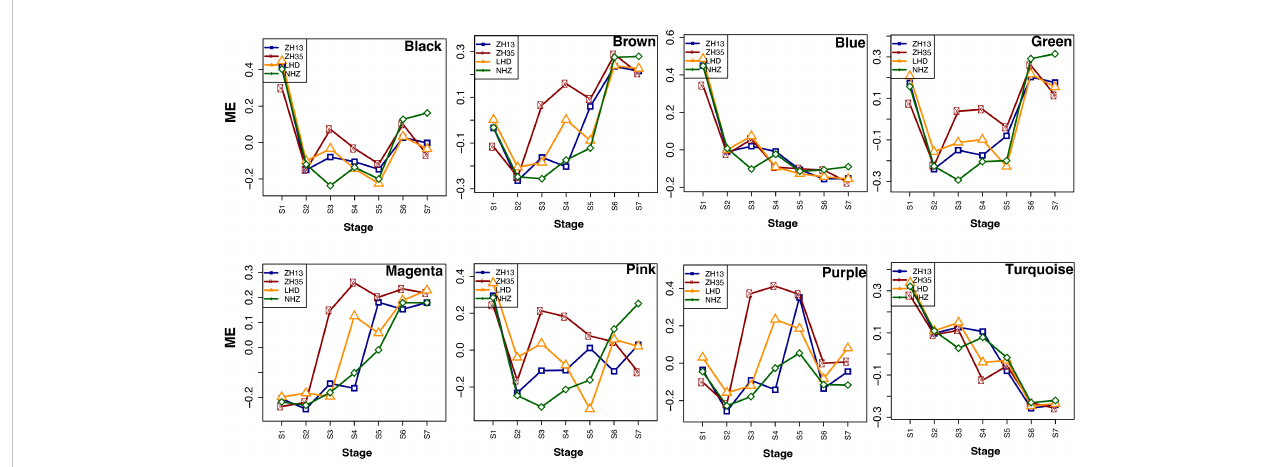
FIGURE 5 Expression pro fi les of the modules at different seed developmental stages in four soybean